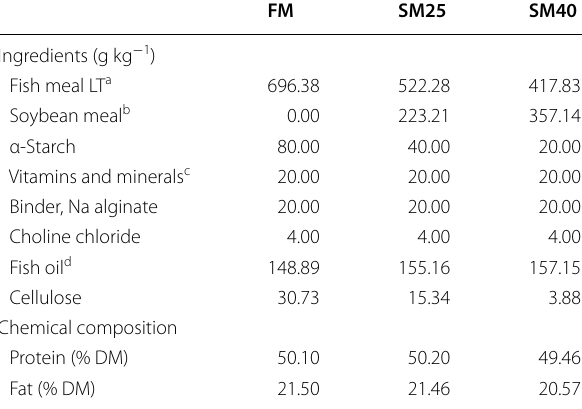
a TripleNine Fish Protein, Denmark b HP 300 Hamlet Protein, Denmark c Roche Vitamin and Mineral mix for Aquaculture No. 5024: vitamin A: